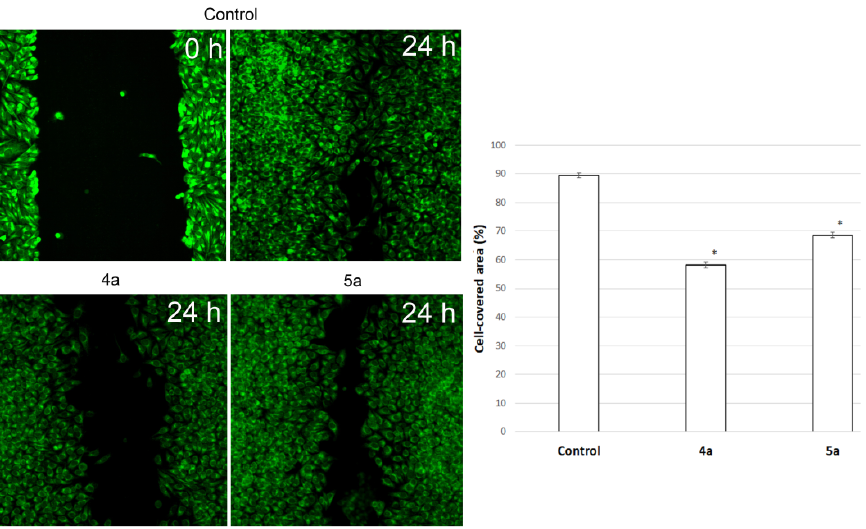
Figure 7. Microscopic images of the HeLa cells wound area in the scratch assay and wound area (%) in the scratch assay after 24 h incubation post spiro-fused cycloadducts 4a and 5a treatment at concentration 10 μ g/mL. * p value < 0.05.